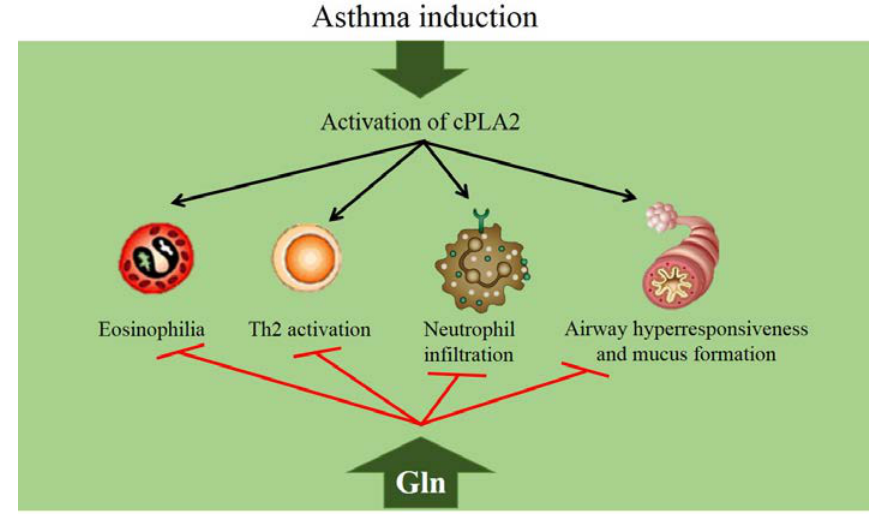
Figure 2. Effects of glutamine in asthma models. cPLA2, cytosolic phospholipase A2; Gln, glutamine; Th, T helper